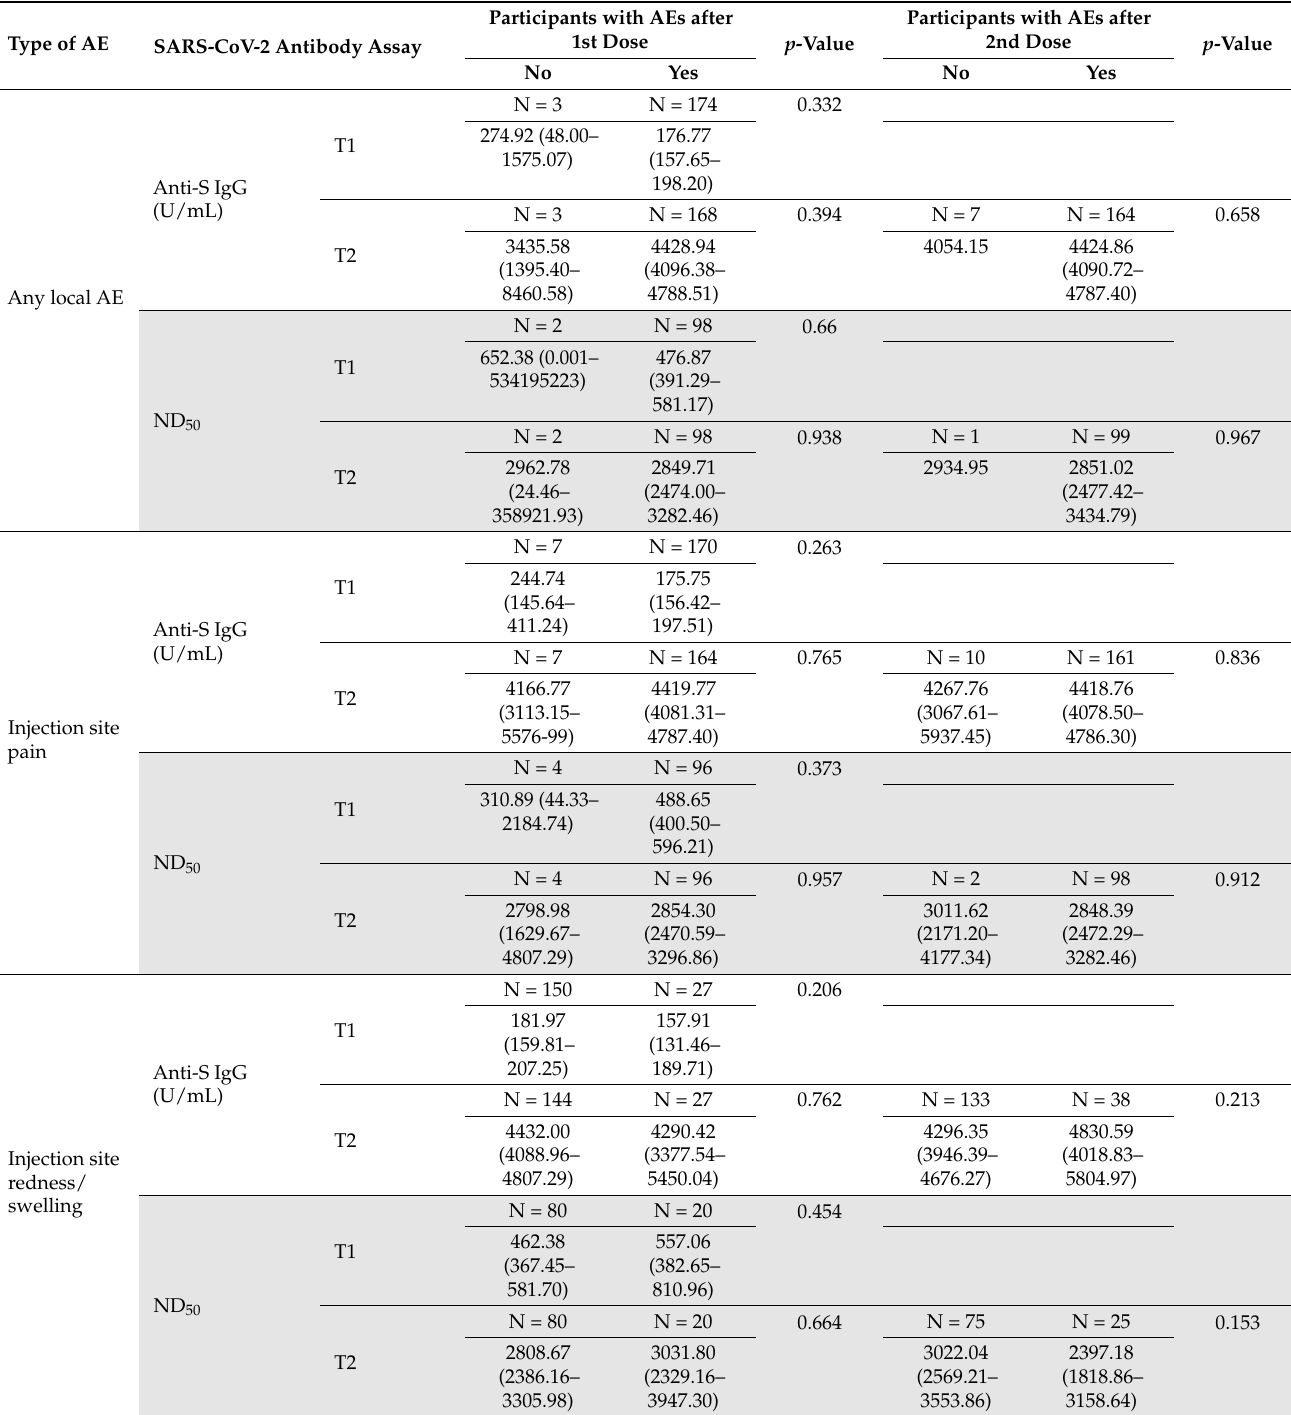
Table 2. Relationship between reactogenicity and antibody response after the mRNA-1273